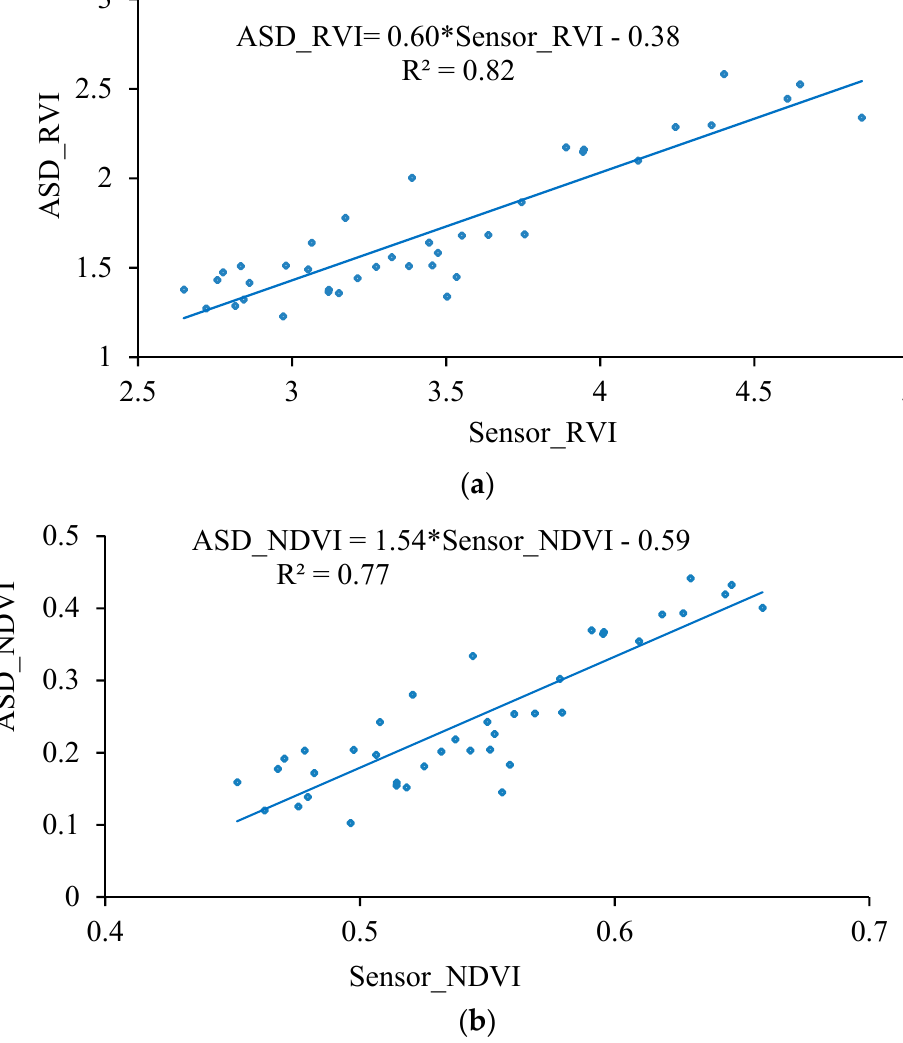
Figure 14. Fitting curves for the hand-held sensor and ASD data. ( a ) NDVI; ( b ) RVI.